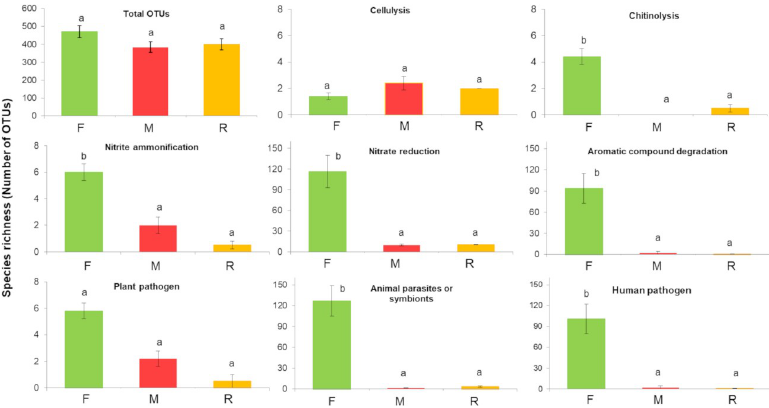
Fig 2. Living bacterial taxonomic richness–totals and numbers in 8 functional groups. The data derived from forest (F), Mine (M) and young mine-rehabilitation plot (R) samples. Data are numbers of OTUs (mean ± SE). Bars not sharing the same superscripts differ significantly ( P <